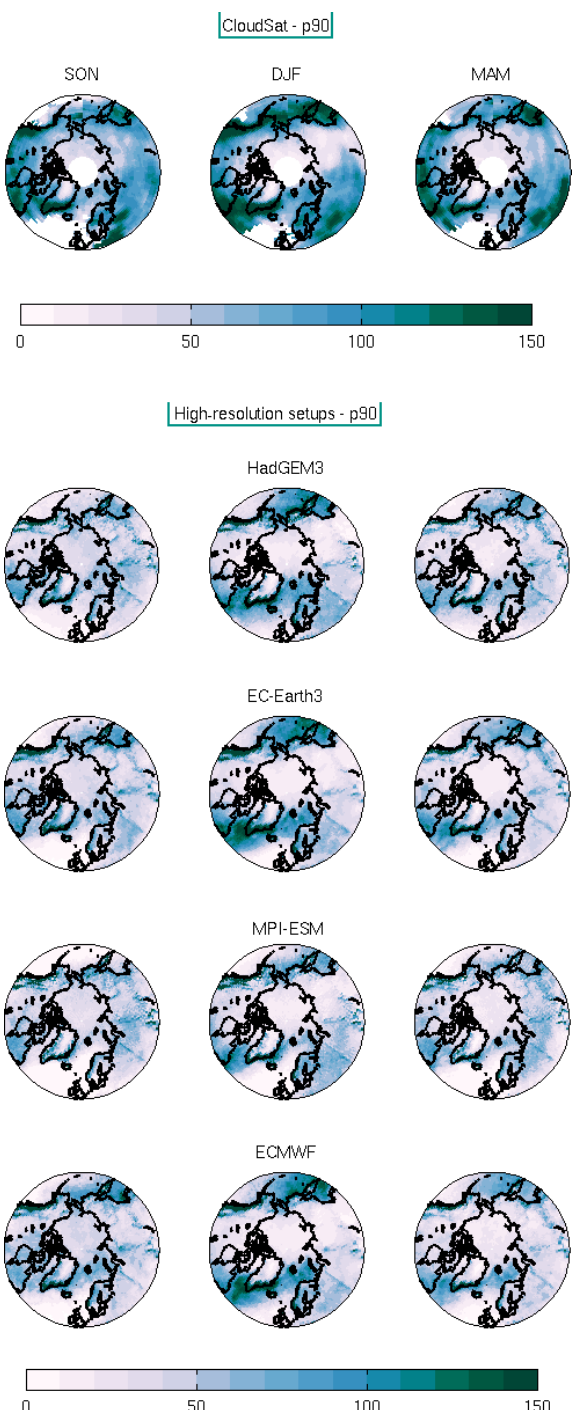
Figure 3. Same as Fig. 1 but at the 90th percentile threshold.